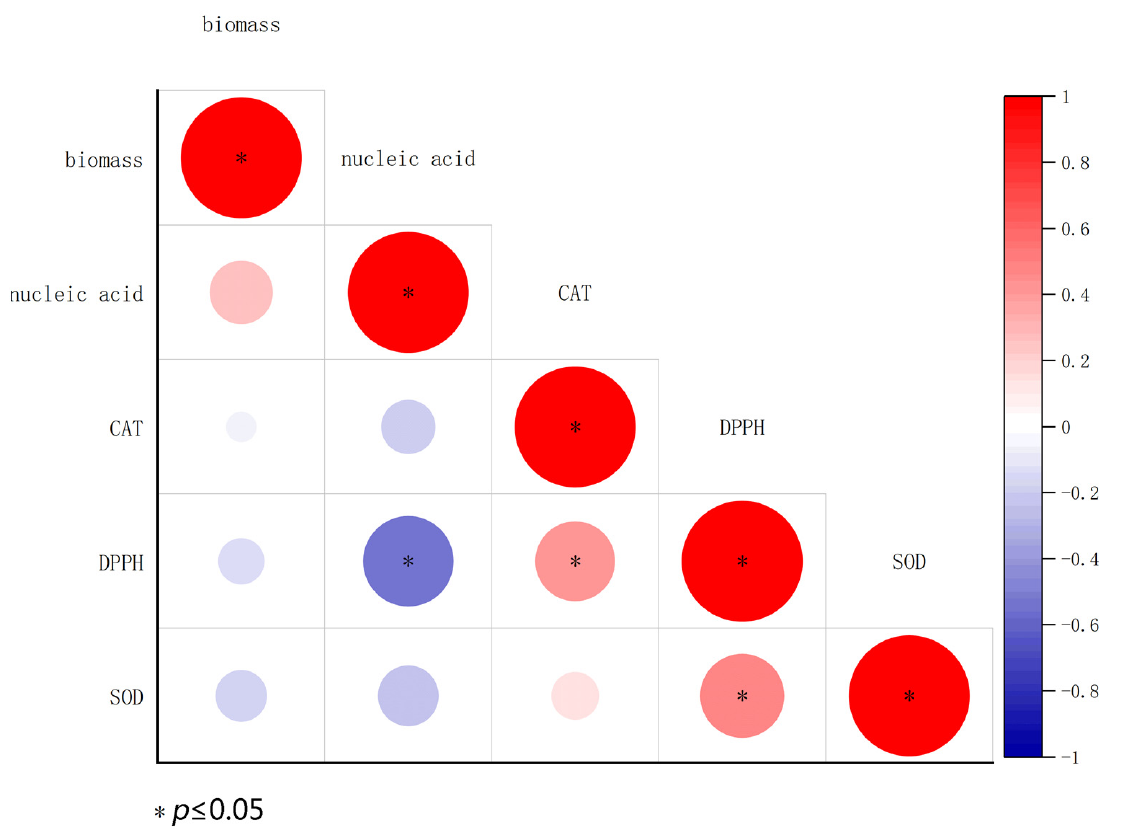
Figure 8. Correlation (Spearman’s) among indicators of Bot. dothidea JNHT01 after biocontrol agent treatment. The asterisks indicate significant differences with a p < 0.05.